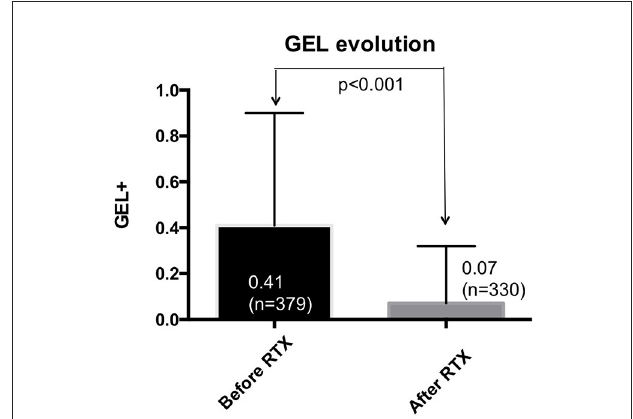
FIGURE2 Gadolinium-enhanced lesions, before and after starting rituximab. Data corresponding to the entire series are shown. A significant reduction in GEL was observed after starting rituximab. GEL, gadolinium enhanced